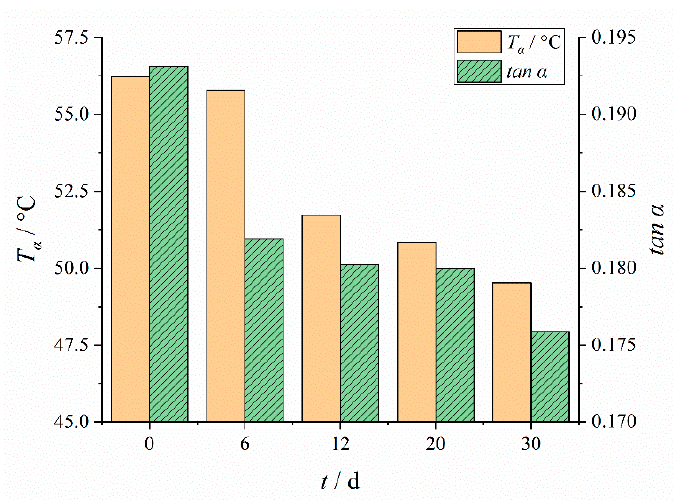
Figure 7. Changing results of T α and tan α with aging time.